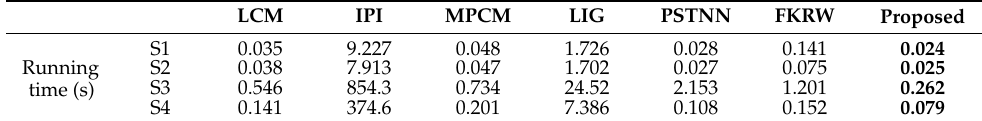
Table 3. The comparison of the running time among different